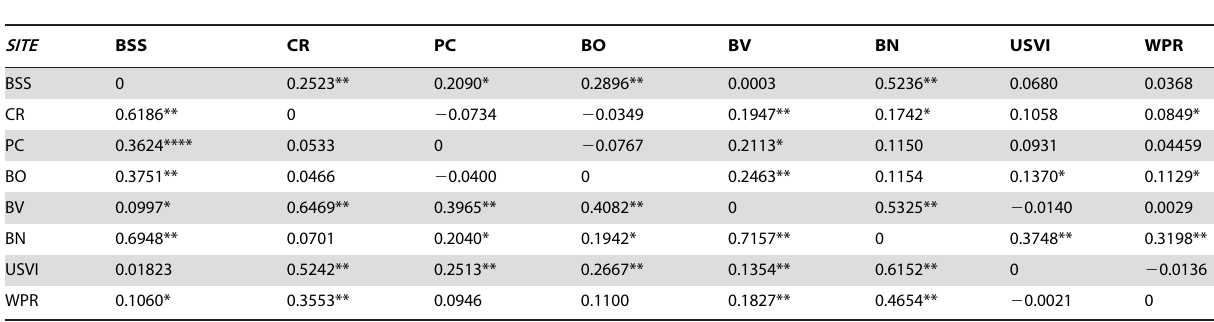
Table 1. Triangular matrices of pairwise F st values for COI and 16S between populations.